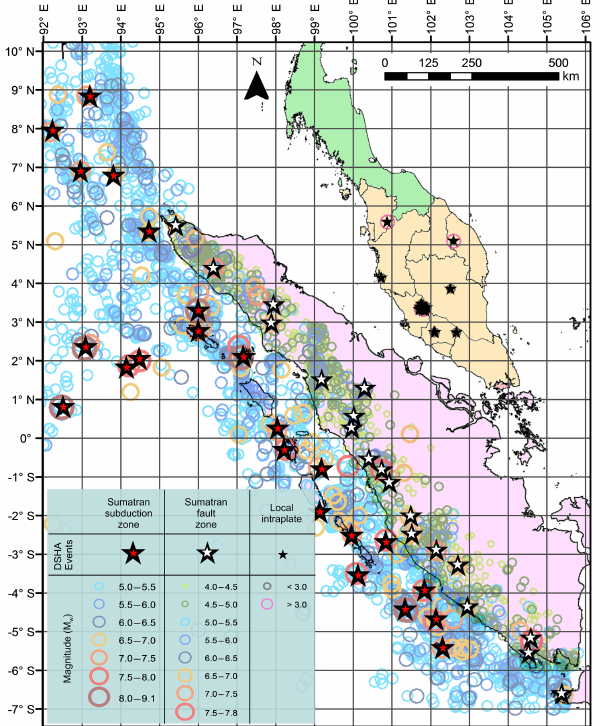
Figure 4. An epicentre map of historical earthquake magnitudes: M w ≥ 5 . 0 for the Sumatran subduction zone, M w ≥ 4 . 0 for the Sumatran fault zone and low-magnitude earthquakes within Penin- sular Malaysia for the period of 1906–2016. The records for these events were taken from USGS earthquake catalogue, MMD and published literature. Earthquake sizes are given on scales and colours proportional to the earthquake magnitudes. The asterisks show the locations of the MPEs utilised for DSHA for each region.